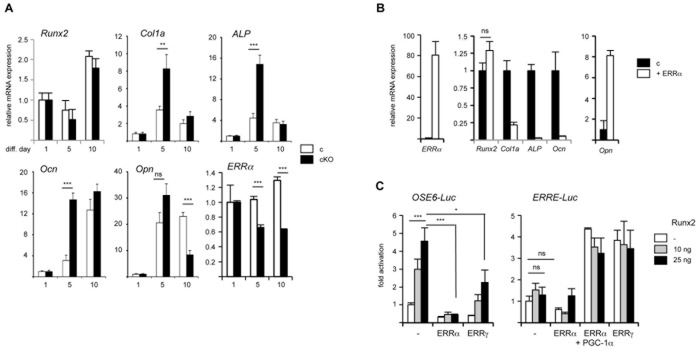
ERRα represses osteoblast differentiation markers.
A. Evaluation of the expression of osteoblast differentiation markers by real time PCR at the indicated time after differentiation of mouse calvarial cells. ALP: alkaline phosphatase; Ocn: osteocalcin; Opn: osteopontin. A single representative experiment (out of three, performed in triplicate) is shown. Data are expressed relative to differentiation day 1 with error bars representing S.D. B. Reintroduction of ERRα in cKO cells normalizes the expression of differentiation parameters. Lentivirus encoding human ERRα was used to infect mouse calvarial cells induced in osteoblastic differentiation. RNAs were extracted after differentiation day 5. Data are expressed relative to control-infected cells (empty lentivirus: c) as mean +/− s.e.m. Differences for each gene are significant (p<0.005) except where indicated. Experiments were performed in triplicate with n = 4. C. ERRα represses Runx2 transcriptional activities. C3H10T1/2 cells were transfected with OSE6-Luc (Runx2-responsive) or ERRE-Luc (ERRα-responsive) plasmid together with the indicated amount of Runx2, and fixed amounts of ERRα or ERRγ, as indicated. CMV-renillaLuc was added as a transfection efficiency control and PGC-1α-encoding plasmid was added together with ERR for the right panel as indicated. Results are expressed as fold activation over transfection with activator and expressed as the average of a typical triplicate experiment (out of three) with error bars representing S.D. *: p<0.05; **: p<0.01; ***: p<0.005; ns: non significant.